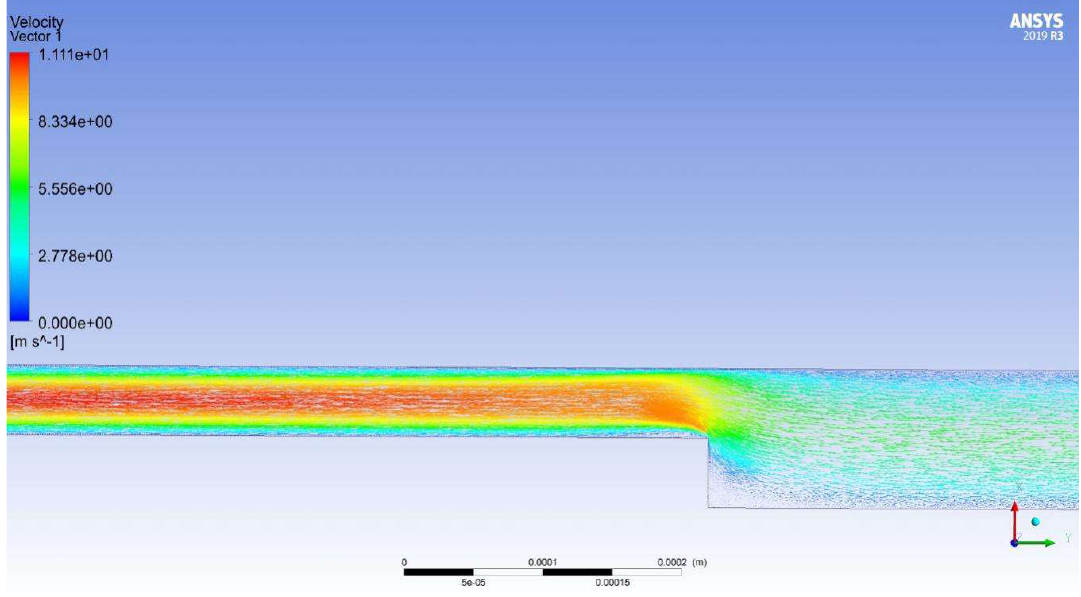
Figure 20. Distribution of velocity vectors in a turbulence model transition SST.